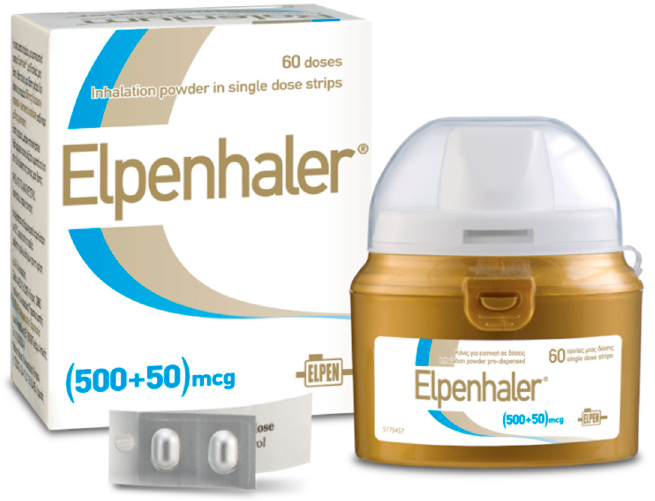
Figure 1. Elpenhaler ® device with the fixed-dose combination of salmeterol/fluticasone propionate (SFC) 50/500 μ g.